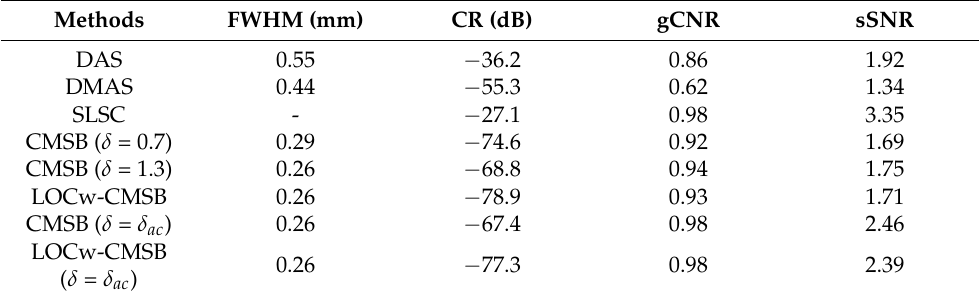
Table 2. Image quality metrics in terms of full-width and half-maximum (FWHM), contrast ratio (CR), generalized contrast-to-noise ratio (gCNR), and speckle signal-to-noise ratio (sSNR) of simulated tissue-mimicking images formed using different methods.